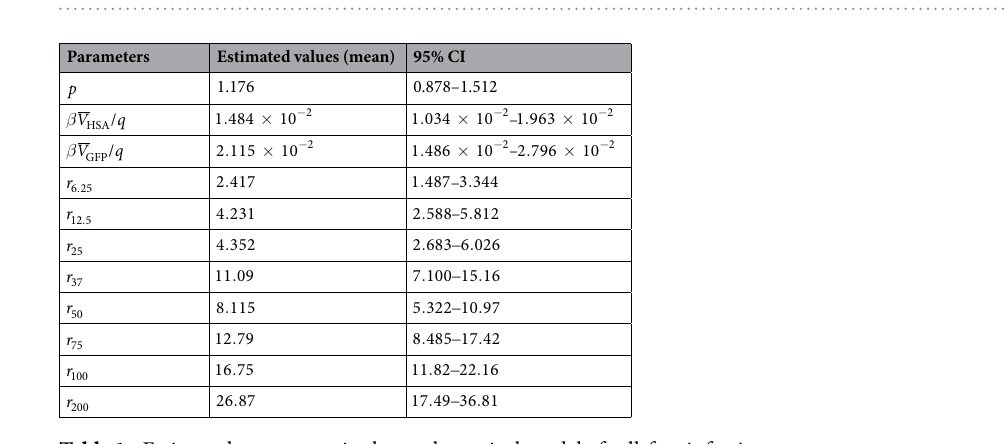
Figure 1. Flow cytometry analysis of single and double HIV-1 infection. Panels represent the following conditions, clockwise starting from the upper left panel: no infection; infection by the HSA virus; coinfection with HSA and GFP viruses, infection by the GFP virus. In each panel, the quadrants correspond to HSA + ( A ); HSA + GFP + ( B ); uninfected cells ( C ); and GFP + ( D ). The percentage of cells in each quadrant is indicated under the letter identifying the quadrant.